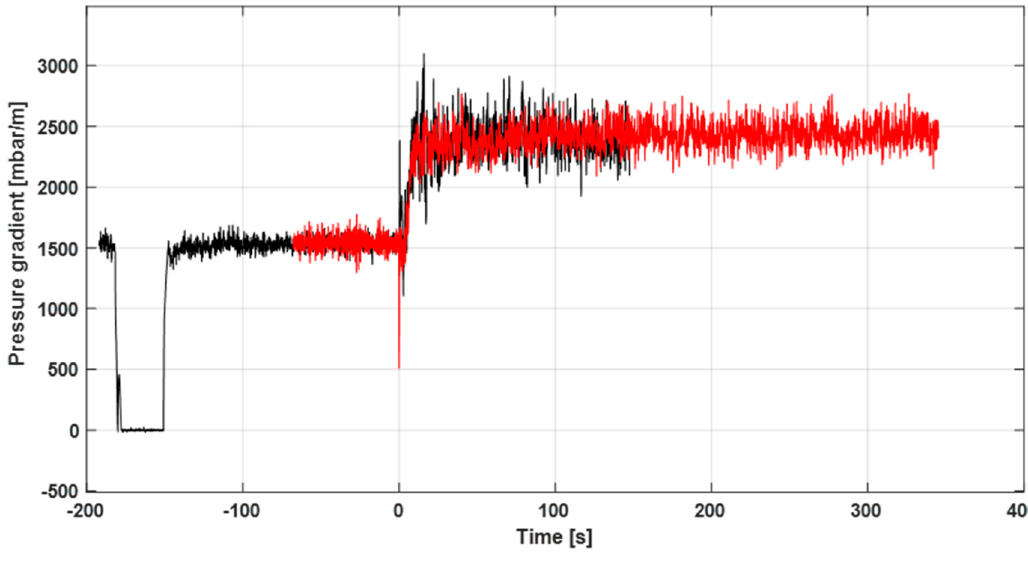
Figure 15. DP1 pressure gradients for the experiments shown in Figure 14 (black) and a repetition test (red).